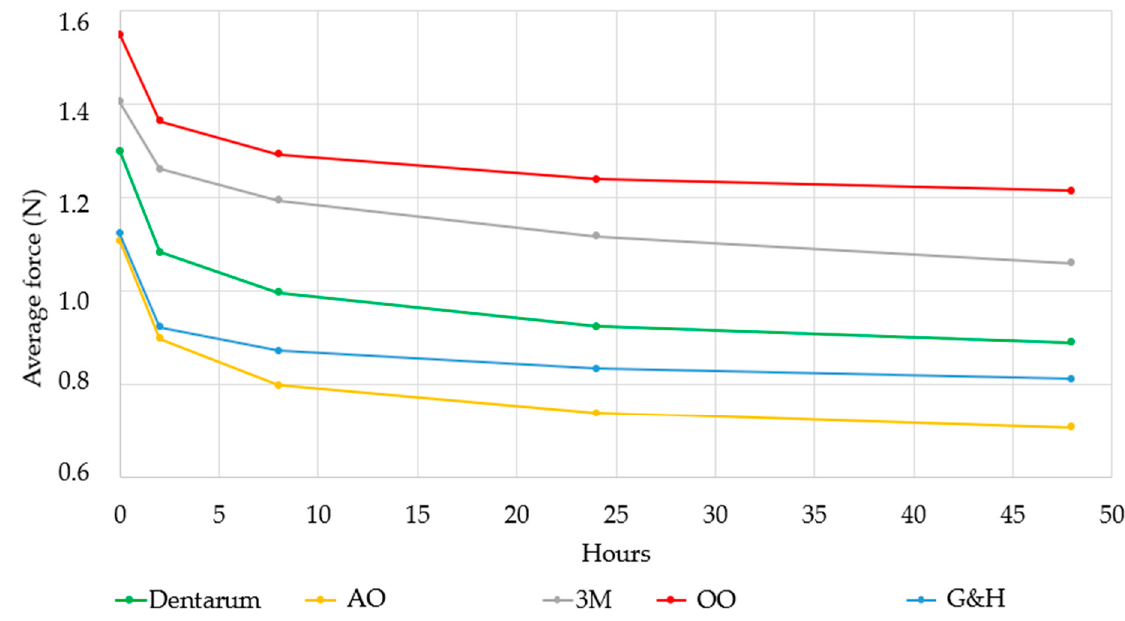
Figure 4. Graph showing the force decrease in five manufacturers at 0, 2, 8, 24, and 48 h. N = newton; AO = American Orthodontics; OO = Ortho Organizers; G&H = G&H Orthodontics.